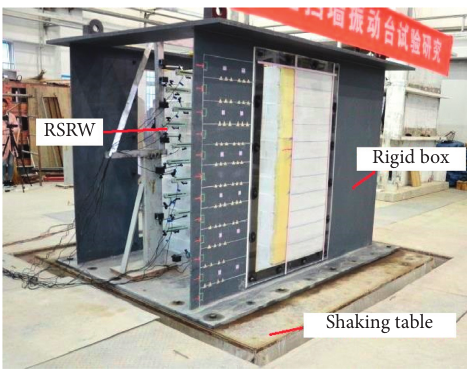
Figure 1: Rigid box and shaking table. Table 1: Technical